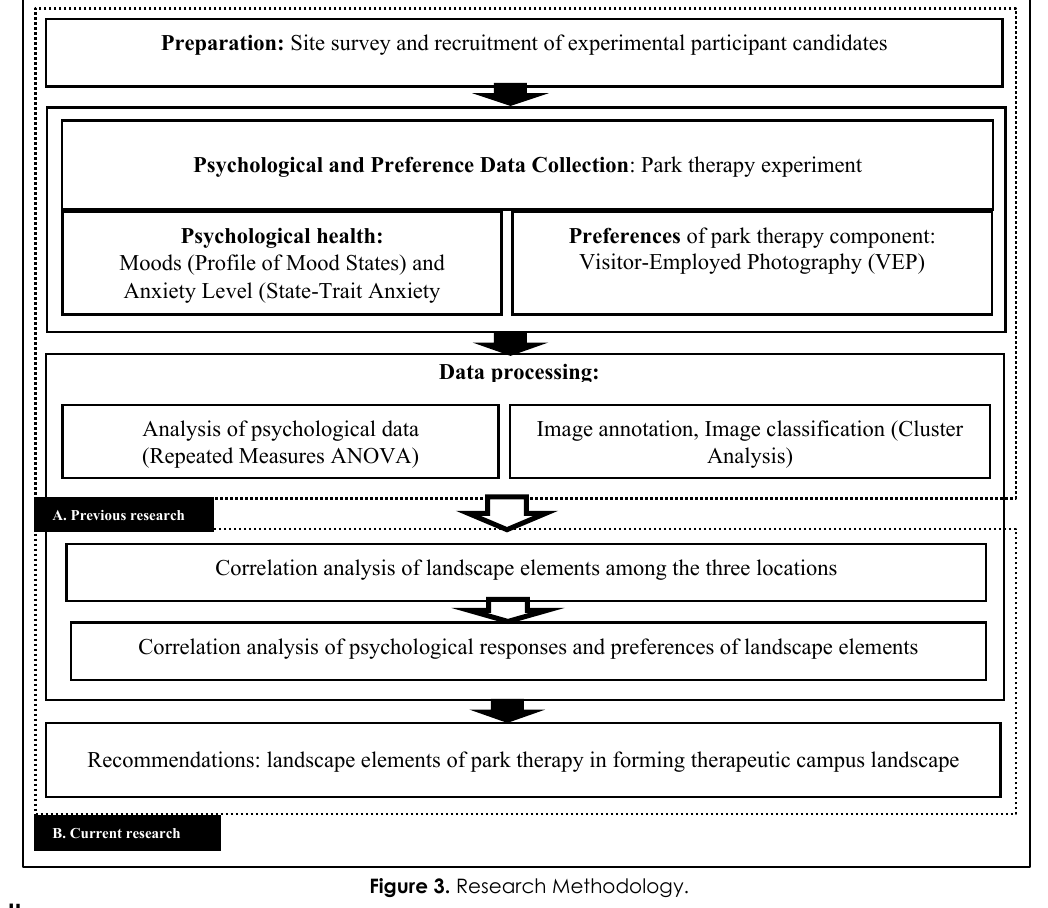
Figure 3. Research